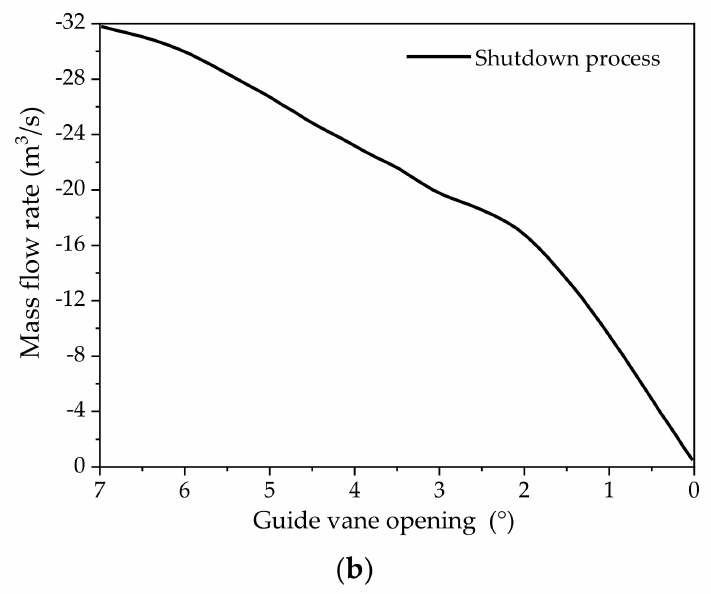
Figure 3. Discharge law of the transient process simulation of the Tianhuangping pumped-storage power station: ( a ) discharge law of the startup process; ( b ) discharge law of the shutdown